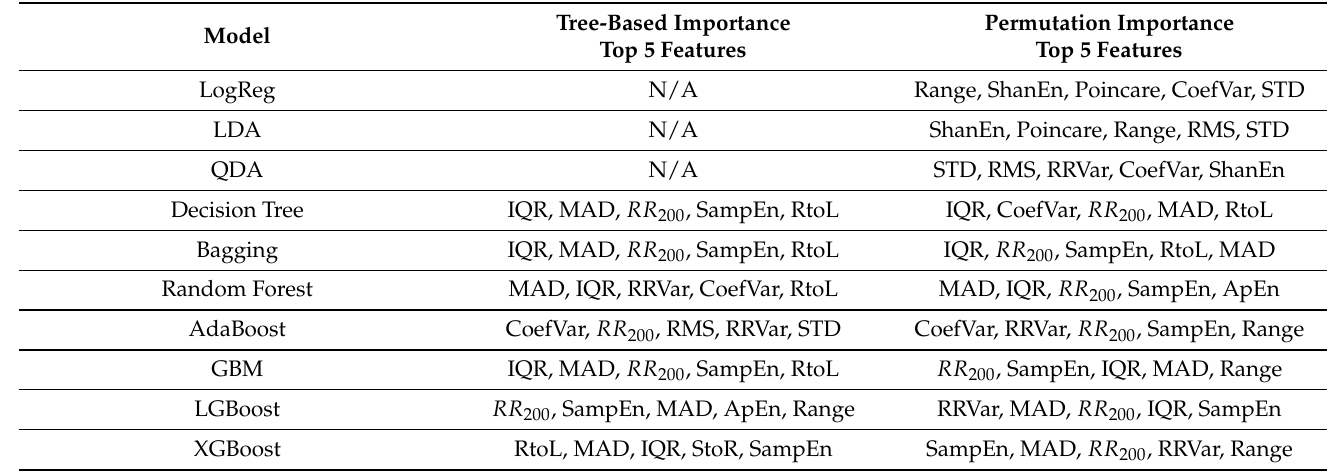
Table 7. Top five features for all models with the 10-s segmentation scheme.